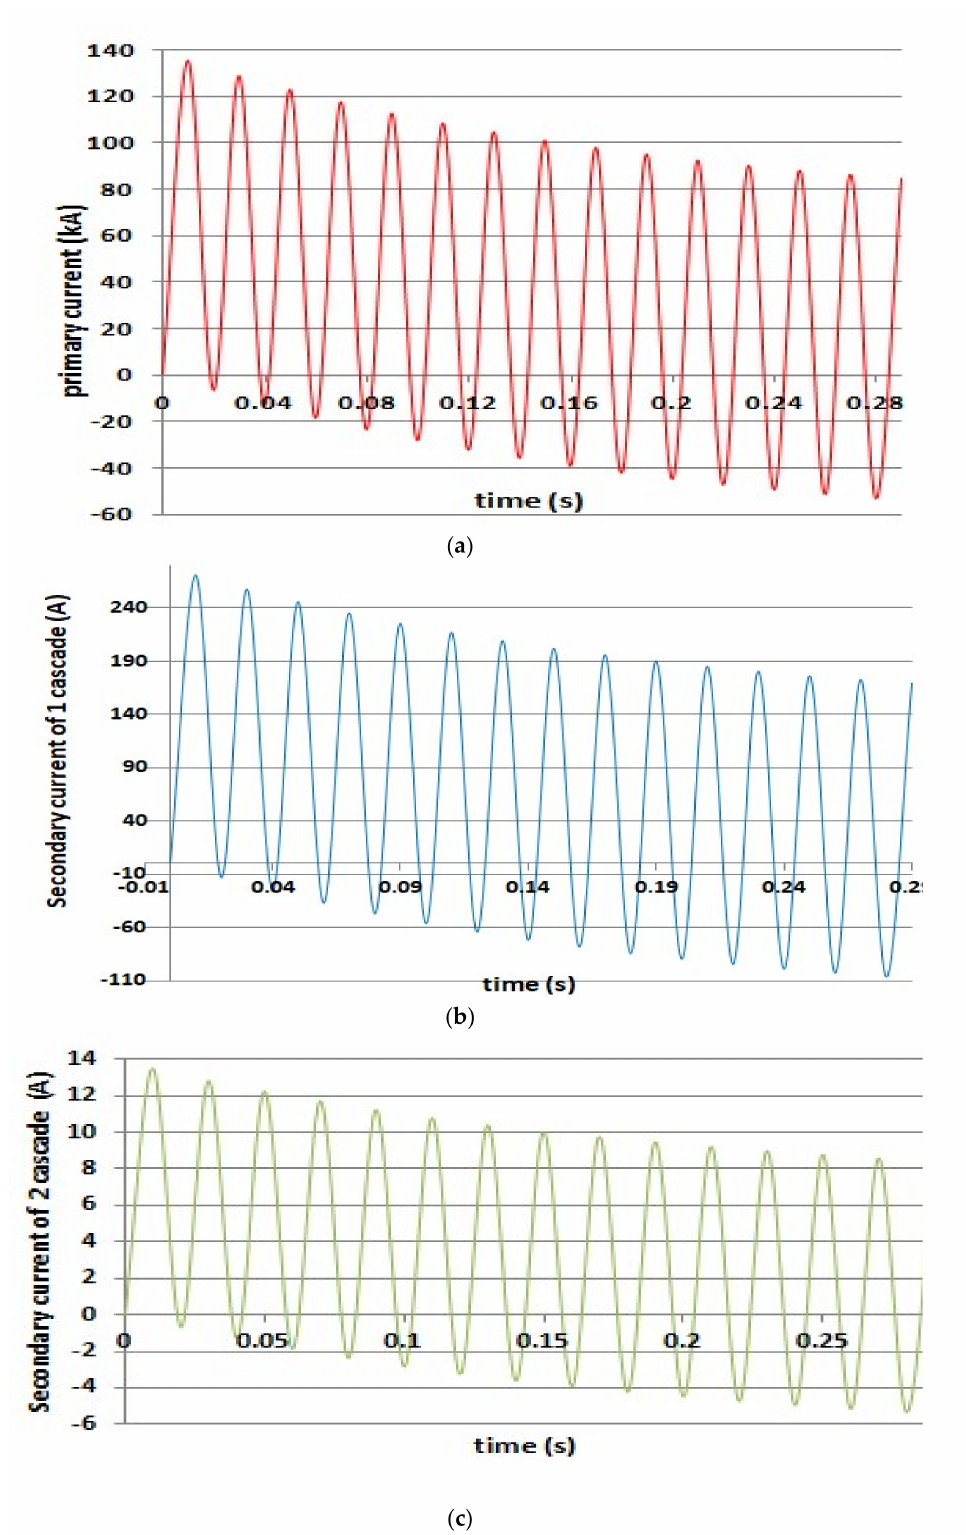
Figure 7. The calculated waveforms of primary ( a ) and secondary short-circuit currents in the first stage cascade (coupling winding) ( b ) and the second stage cascade ( c